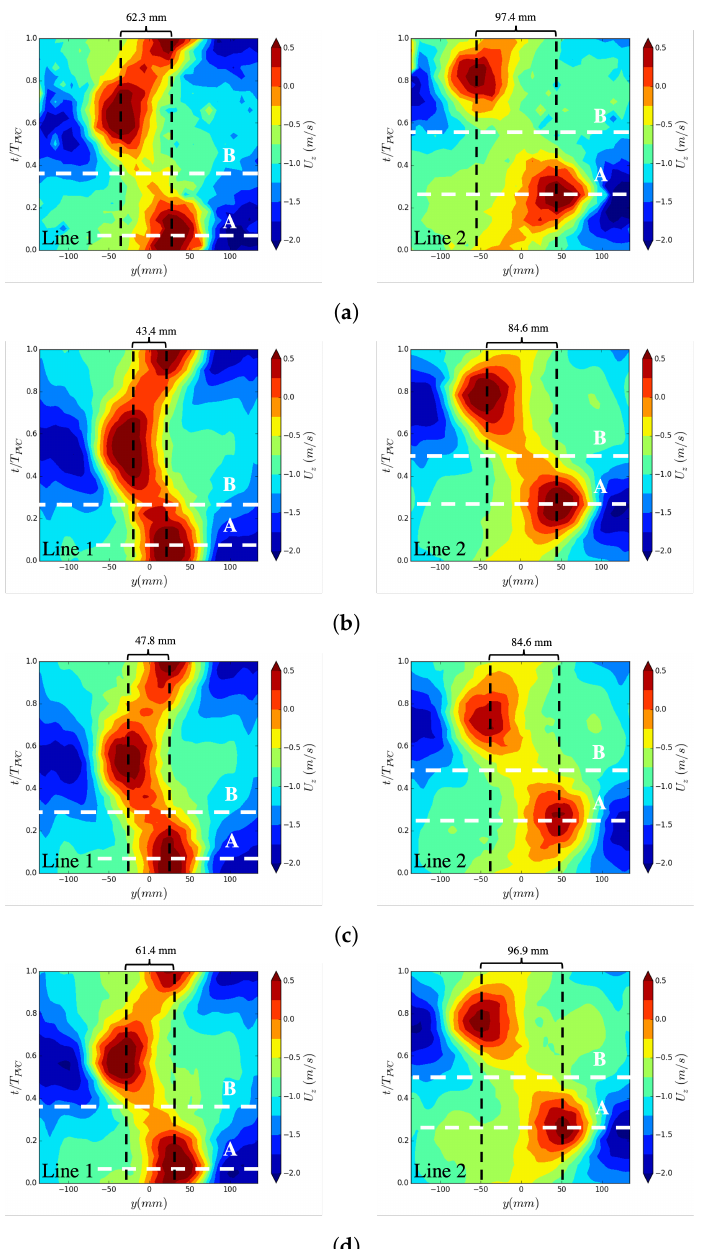
Figure 5. Phase-averaged axial velocity over Lines 1 and 2 in the experiment and simulations, instance A corresponds to RVRs being on the line and instance B corresponds to RVRs leaving the lines. ( a ) Exp., ( b ) SAS, ( c ) zonal WMLES, ( d ) WMLES